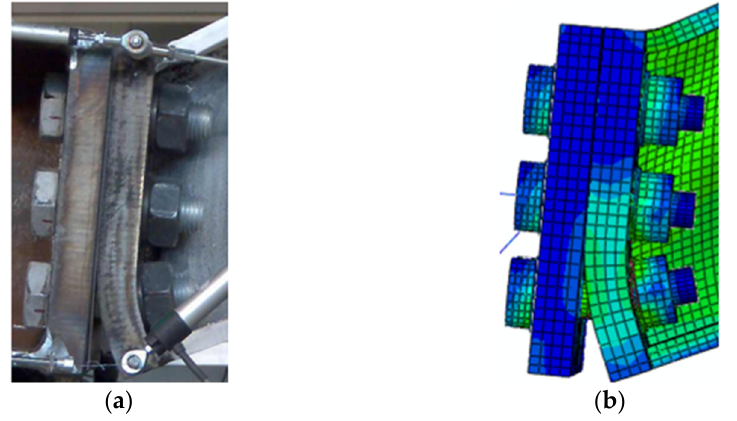
Figure 10. Comparison between the deformed shape of the experimental tests ( a ) and the FEM simulations ( b ) where the bending deformation of the bolts is highlighted.